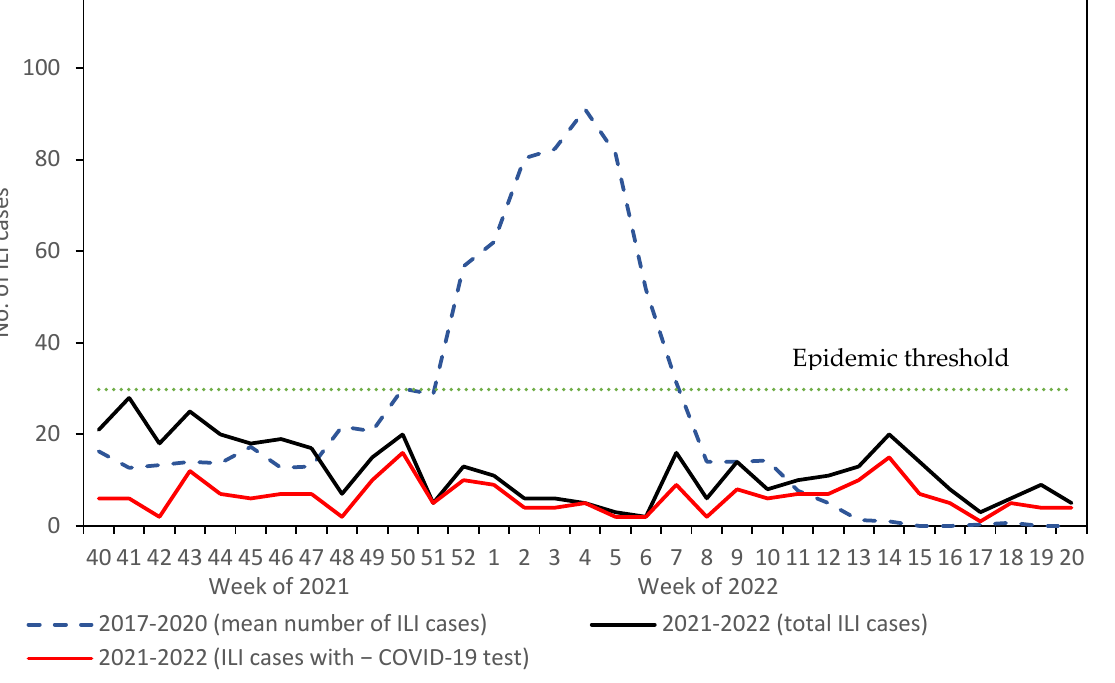
Figure 1. Number of influenza-like illness (ILI) cases reported per week in the 2021–2022 influenza season and mean number of ILI cases reported per week in 2017–2020. The epidemic threshold for the 2021 − 2022 influenza season was determined using the moving epidemic method (MEM) and influenza surveillance data obtained from sentinel pharmacies for the 2017 − 2018, 2018 − 2019 and